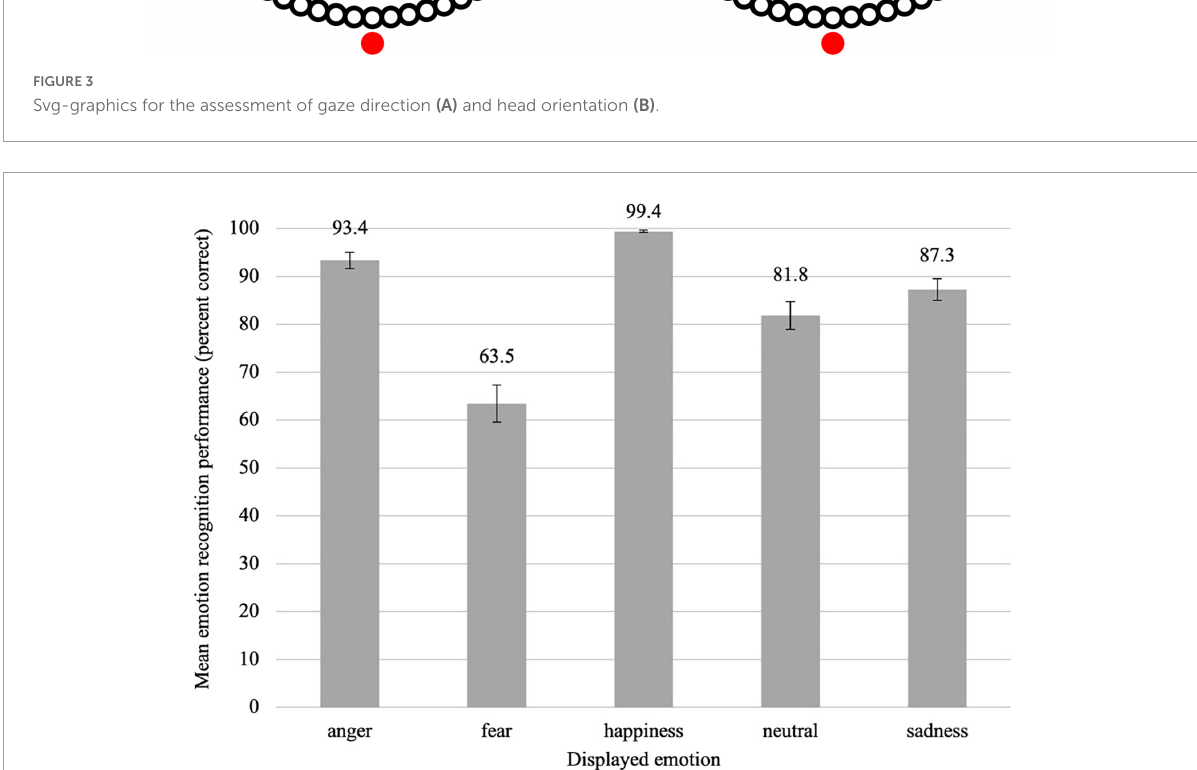
FIGURE4 Mean emotion recognition performance in percent correct for uncovered faces as a function of the displayed emotion, averaged across all gaze directions and head orientations. Error bars indicate the standard error of the mean (SEM) of the 39 individual data points in each